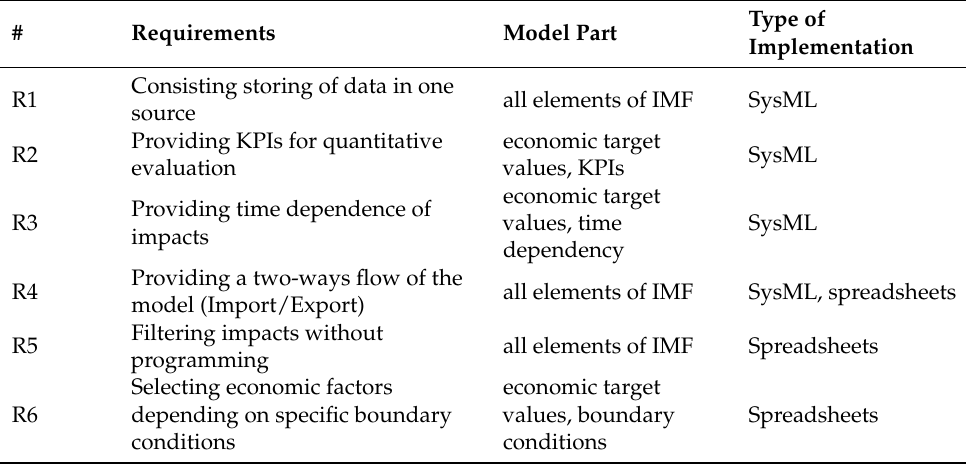
Table 1. Requirement’s